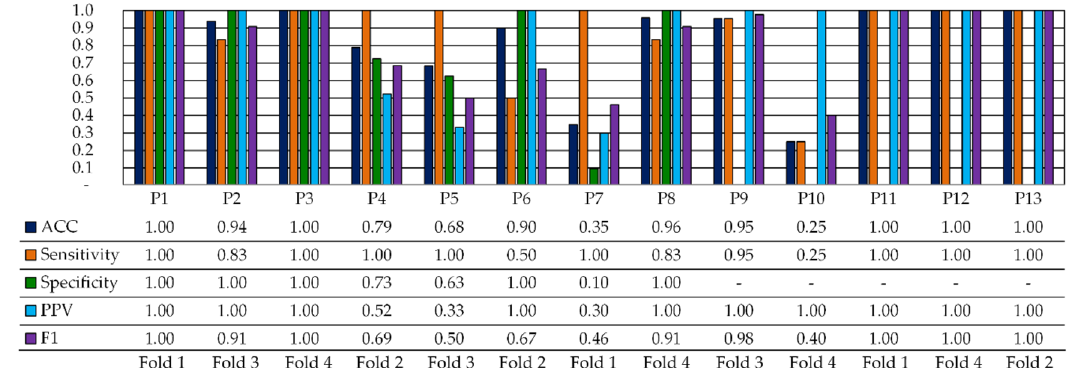
Figure 12. Average image classification results of each fold in the test set using both metrics (BA and Sensitivity) for the hyperparameter optimization of the SVM Linear kernel.